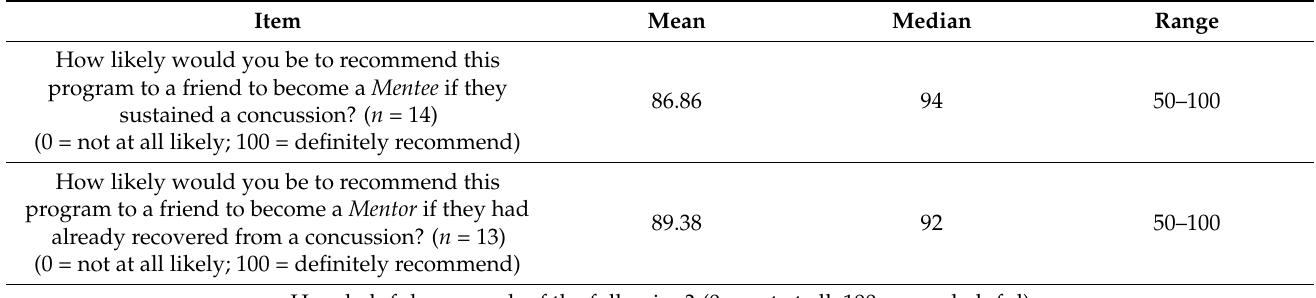
Table 3. SUCCESS Mentee Post-Mentoring Feedback Survey.